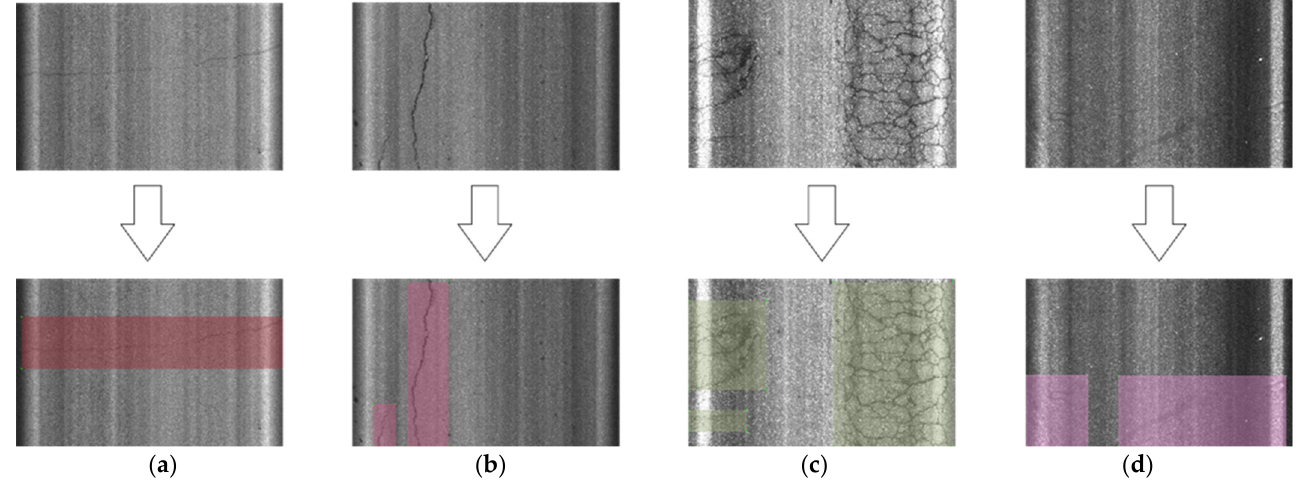
Figure 1. Image annotation visualization. ( a ) Transverse cracks; ( b ) longitudinal cracks; ( c ) alligator crack; ( d ) crack sealing.